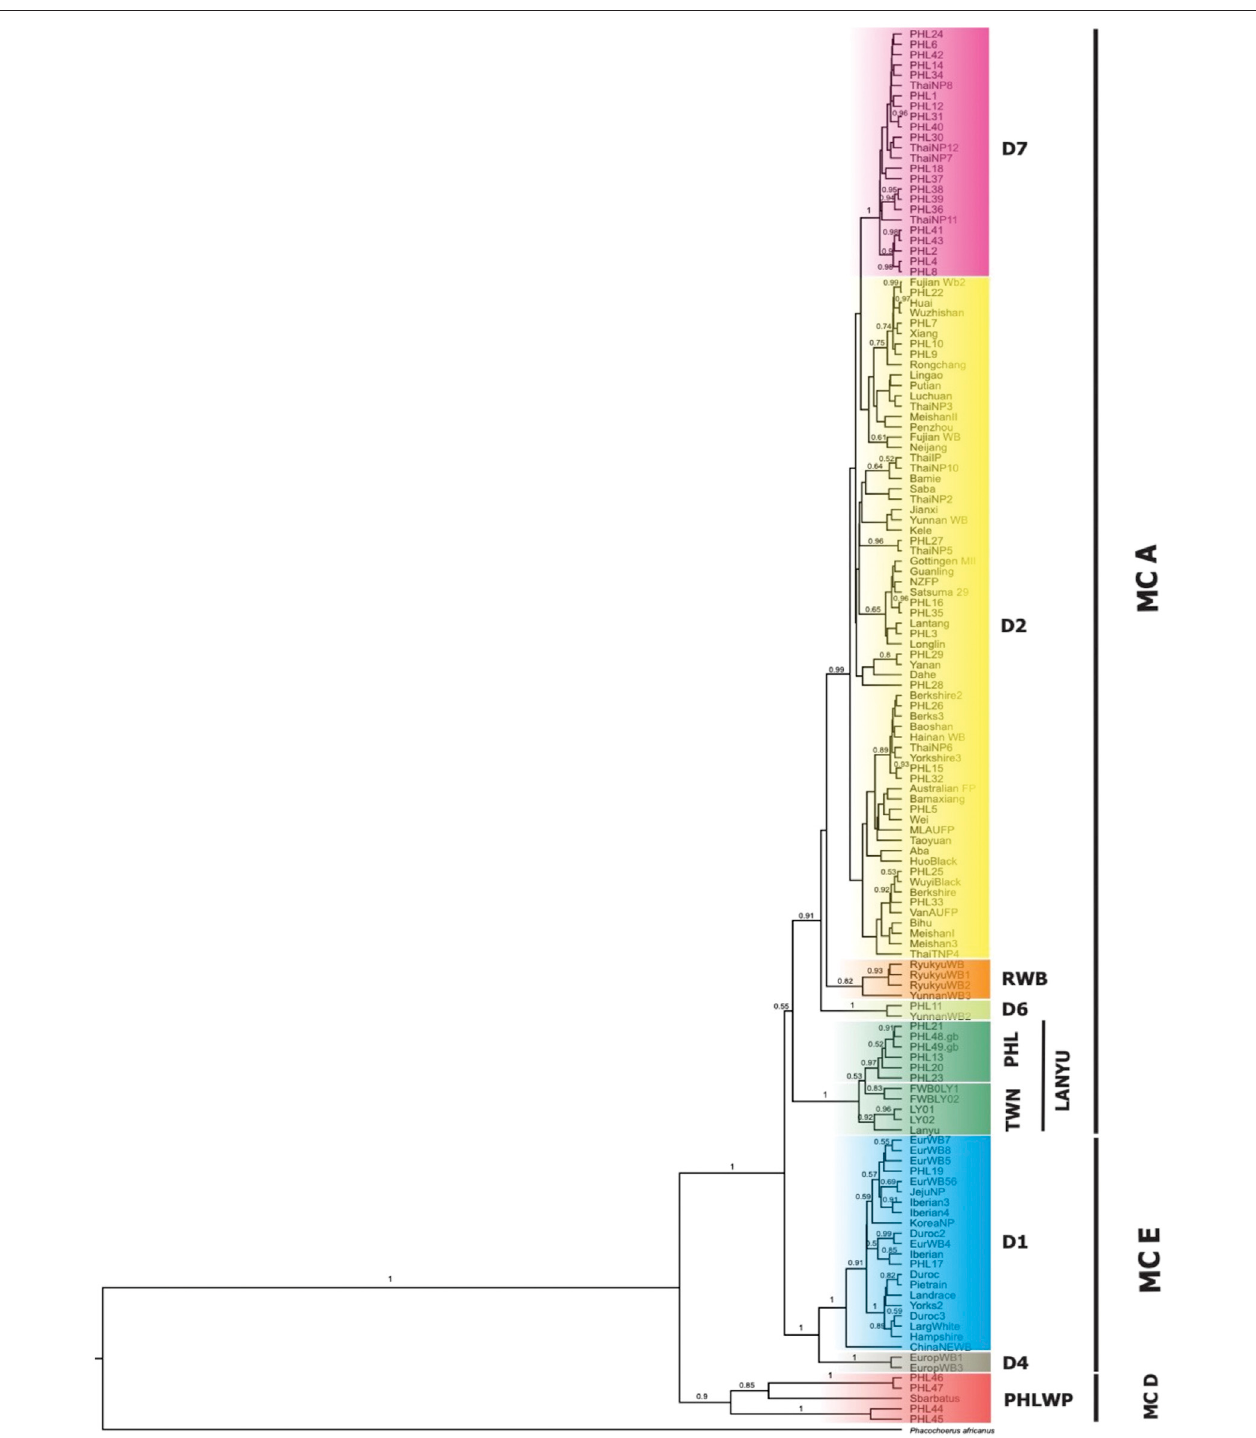
FIGURE 3 | Bayesian tree inference with HKY + G + I as the best- fi tted model using MrBayes 3.2 with Warthog ( Phacochoerus africanus ) as the outgroup. All Philippine pig haplotypes (PHL1-49) were combined with the downloaded sequences from GenBank classi fi ed as domestic and wild Sus scrofa corresponding to their geographic origin. Macro-clades (MC) A and E represent Asian and European pigs, respectively, forming further subclades. The MC D was designated for Philippine pig haplotypes that were outside the Sus scrofa lineages.